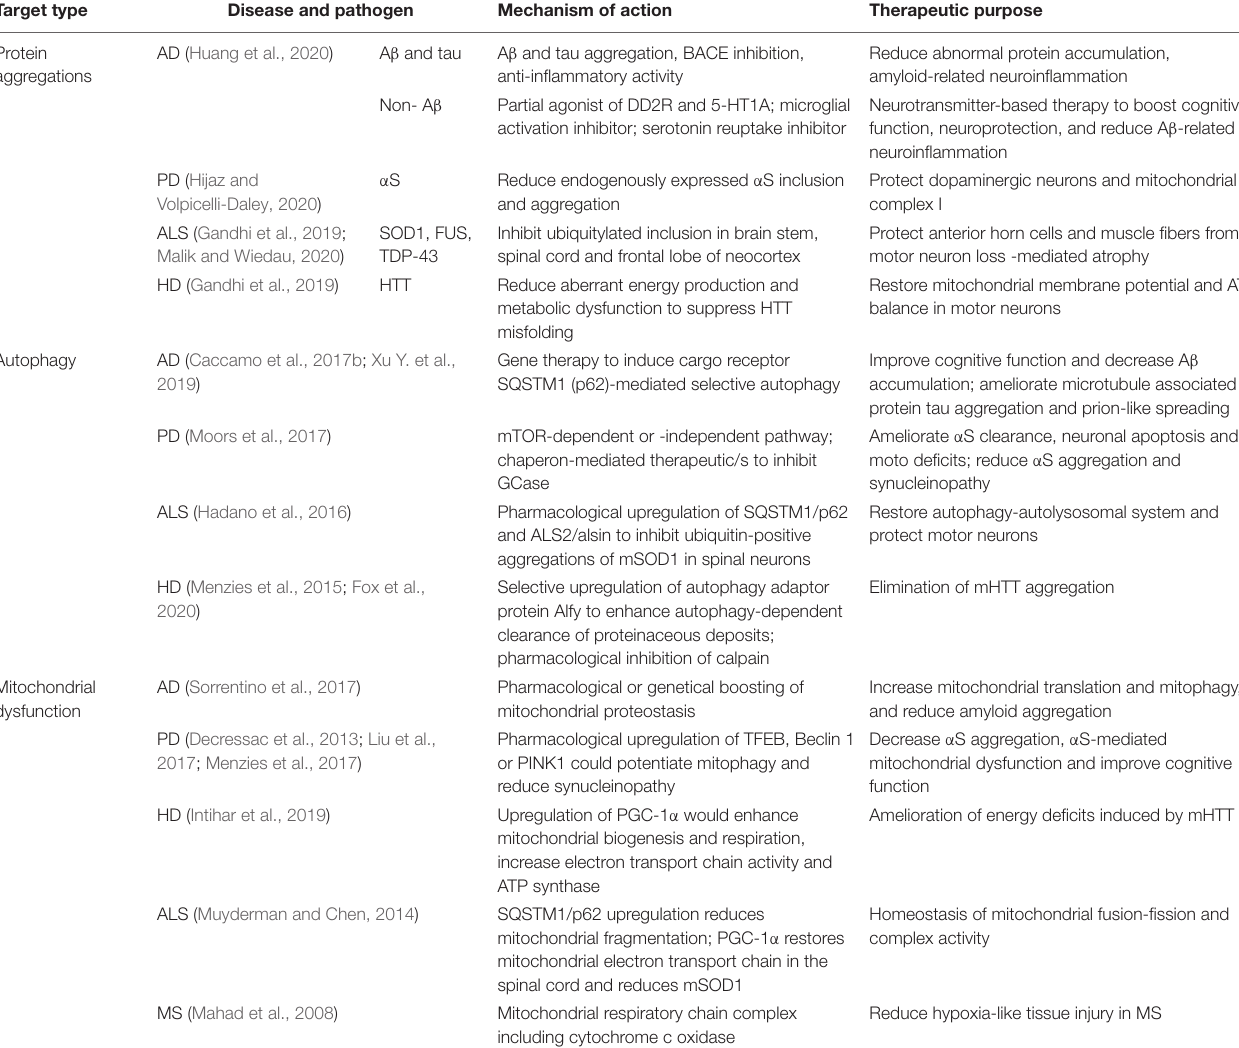
TABLE 1 | Therapeutic strategies that need further attention to intervein ageing-associated neurodegeneration. Target